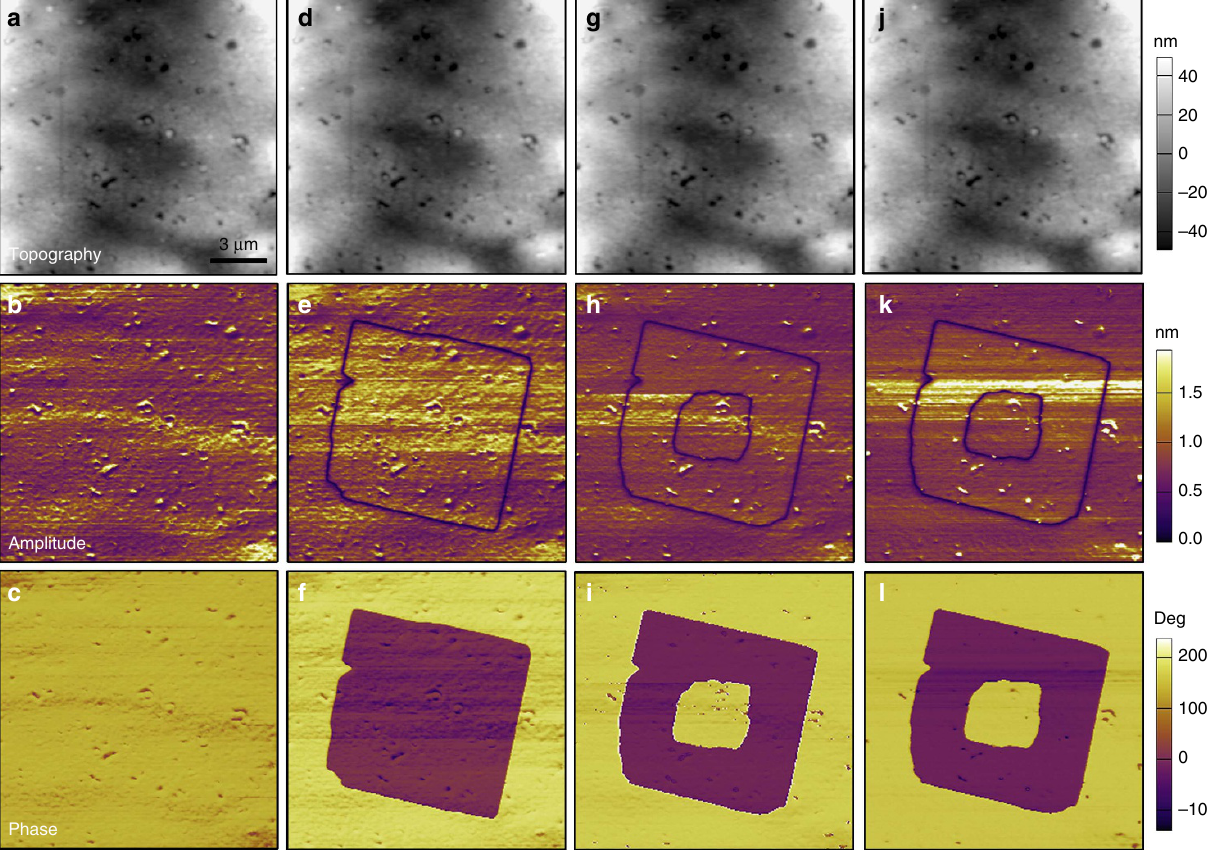
Figure 8 | Polarization reversal of 1 measured from a film. The panels in each column are arranged as the sequence: the topographic image (up), the vertical PFM amplitude image (middle) and the phase image (bottom) of the surface. ( a – c ) Images for the initial state. ( d – f ) Images for the state after the first switching operation, produced by scanning with the tip bias of (cid:2) 60V. ( g – i ) Images for the state after the succeeding back-switching operation, produced by scanning with the tip bias of þ 60V. ( j – l ) Images for the state after 18h. The purple and yellow regions in phase images indicate the regions with polarization oriented upward and downward